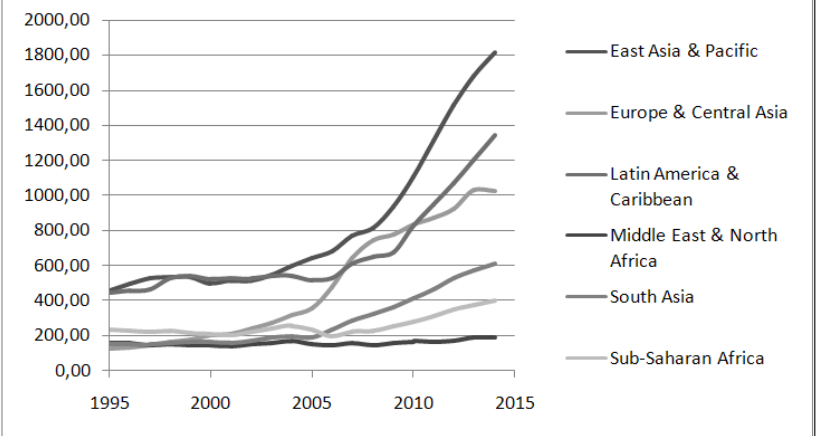
Fig. 9. Trends in total gross external debt